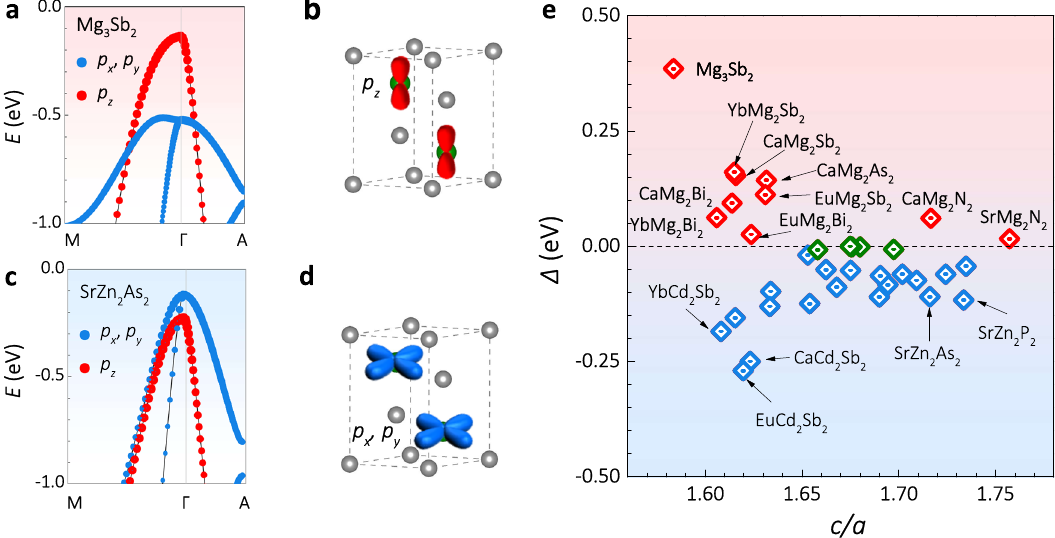
Fig. 6 The band structure of AB 2 X 2 Zintl phase compounds. a Orbital projected band structures of Mg 3 Sb 2 . b Schematic diagram of the p z orbital- dominated hole transport in Mg 3 Sb 2 . c Orbital projected band structures of SrZn 2 As 2 . d Schematic diagram about ( p x , p y ) orbitals-dominated hole transport in SrZn 2 As 2 . e Crystal fi eld splitting energy versus lattice ratio c / a for AB 2 X 2 Zintl phase